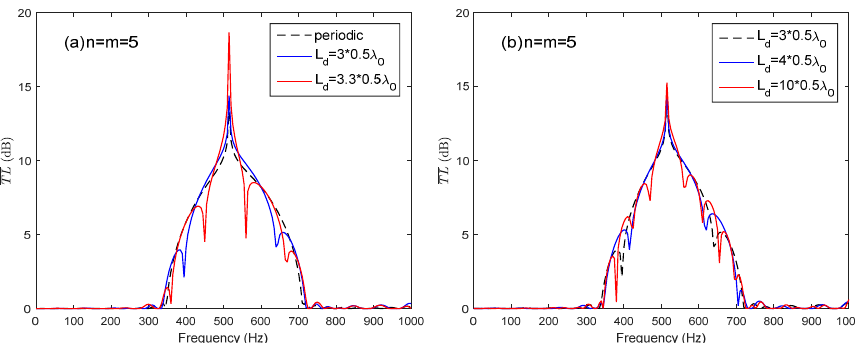
Figure 7. The average transmission loss of the HR array with respect to different connection tube lengths L d between the two periodic parts: ( a ) the periodic one versus two arrays with L d = 3 × 0.5 λ 0 and L d = 3.3 × 0.5 λ 0 respectively; ( b ) three arrays with L d = 3 × 0.5 λ 0 , L d = 4 × 0.5 λ 0 , and L d = 10 × 0.5 λ 0 respectively.